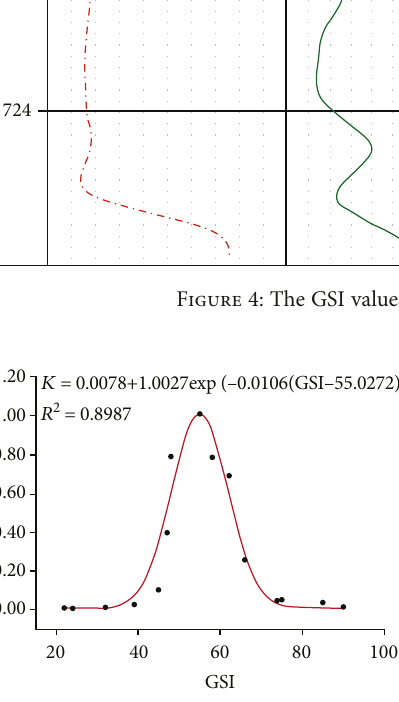
Figure 5: The relationship between GSI value and